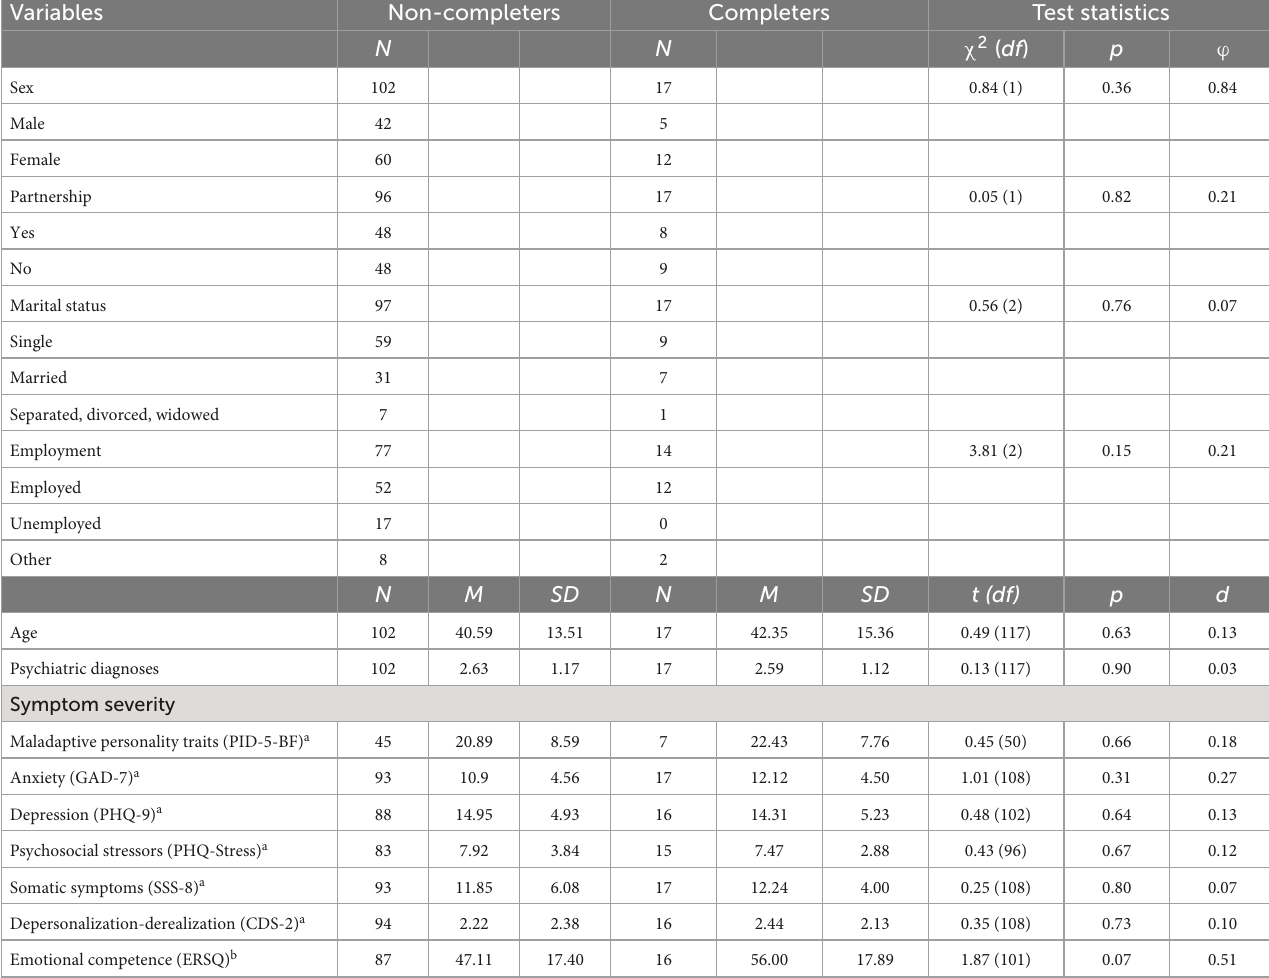
TABLE 3 Descriptive and test-statistics of the comparison between non-completers and completers. Variables